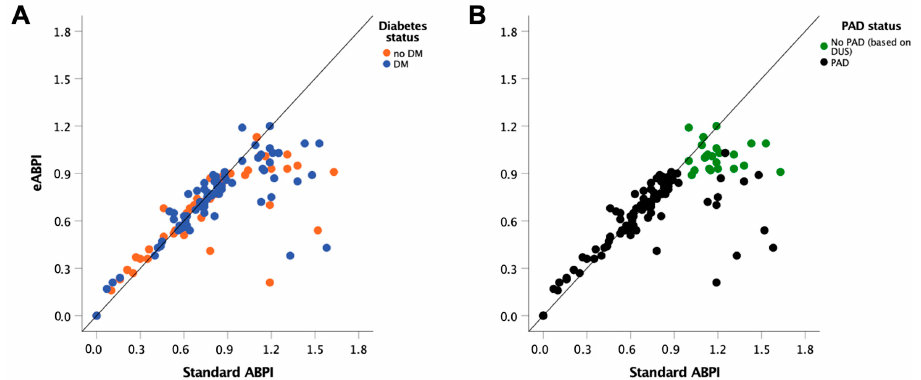
Figure 4. Scatter plots showing individual data of n = 129 legs with standard ABPI vs. angle-corrected eABPI in patients without previous angioplasty. Individual data points labelled according to ( A ) diabetes mellitus (DM, n = 78, 56%) status and ( B ) presence of peripheral artery disease (PAD, n = 102, 73%) according to duplex ultrasound (DUS) imaging reference. We then compared the performance of eABPI and ABPI to diagnose PAD (diagnosis based on Duplex ultrasonography) using ROC analysis, including the legs of patients in which both eABPI and standard ABPI were present. For both eABPI and standard ABPI, the higher ankle value of dorsalis pedis and posterior tibial artery was used, and PAD patients with recent angioplasty were excluded from this analysis as the procedure often